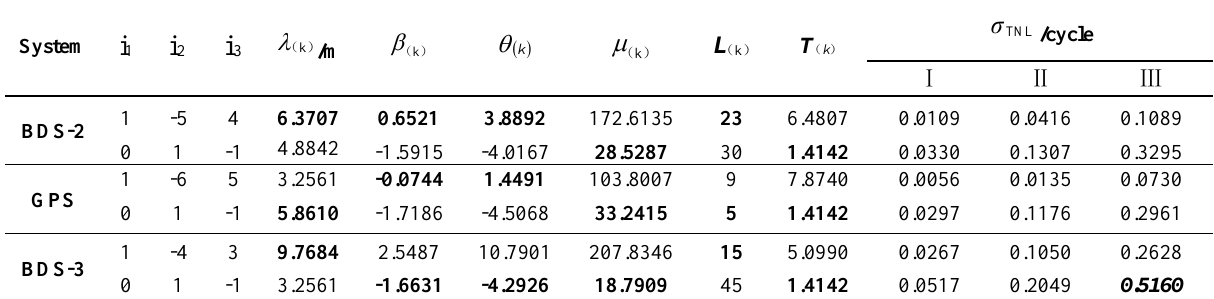
Table 3. Optimal combinations and parameters of triple-frequency signals for BDS-2/GPS/BDS-3